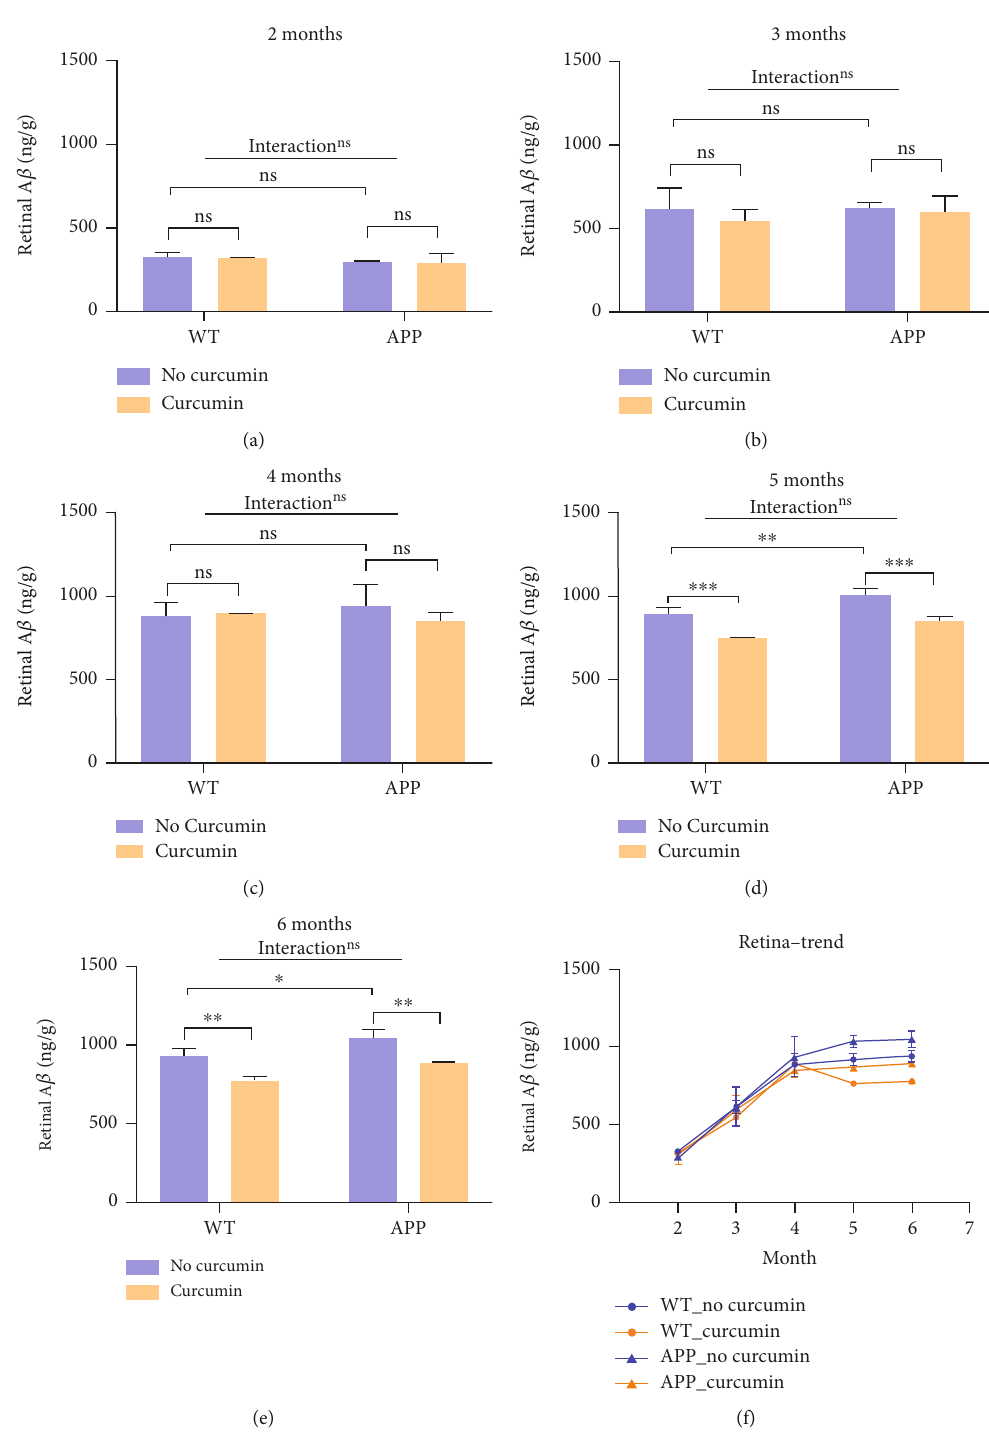
Figure 3: E ff ects of curcumin on the A β level in the retina. Abbreviations: APP: APPswe/PS1dE9; WT: wild type; APP curcumin ( n = 19 ); APP : APP mice not given curcumin ( n = 17 ); WT N curcumin ( n = 17 ); ∗ P < 0 : 05 ; ∗∗ P < 0 : 01